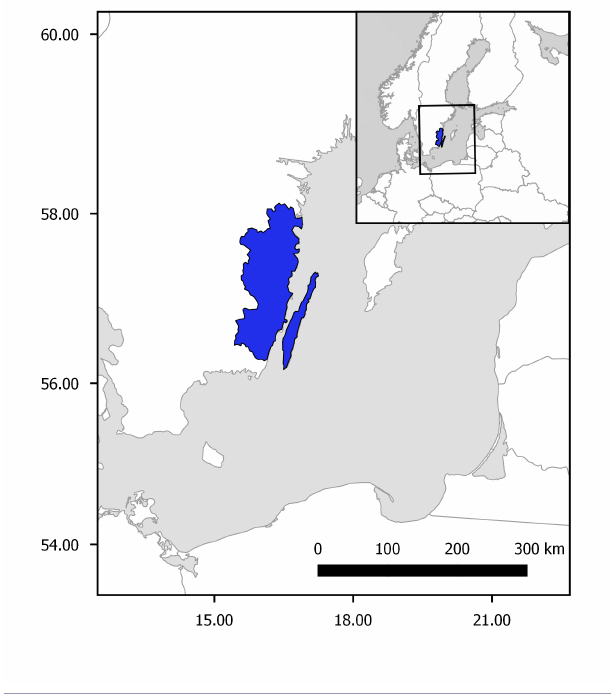
Fig. 1. Map of the location of Kalmar County in